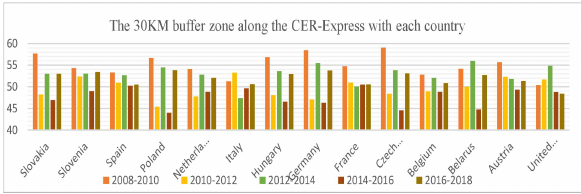
Fig. 3. From 2008 to 2018, the mean CEI values of the countries along the CER-Express Express (European section) were evaluated every two years, with the X-axis corresponding to the countries involved in the area along the route and the Y-axis corresponding to the mean CEI values.